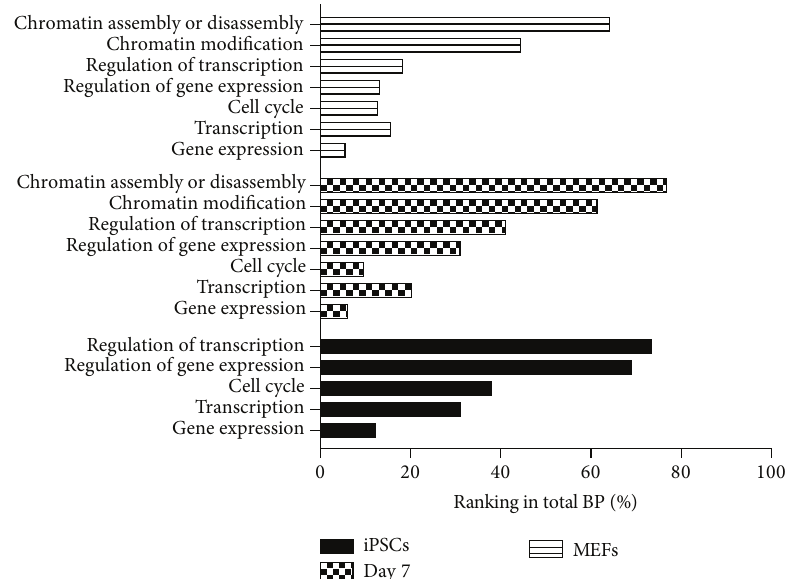
Figure 4: Rank of the same biological process in different samples. Ranking depicts biological processes in order of changes to expression of genes in which H2A.Z was incorporated. The total number of biological processes in distinct samples was normalized as 100, and the enrichment of selected processes is presented as a percentage. The shorter bar indicates the higher order in GO categories, which means higher activity